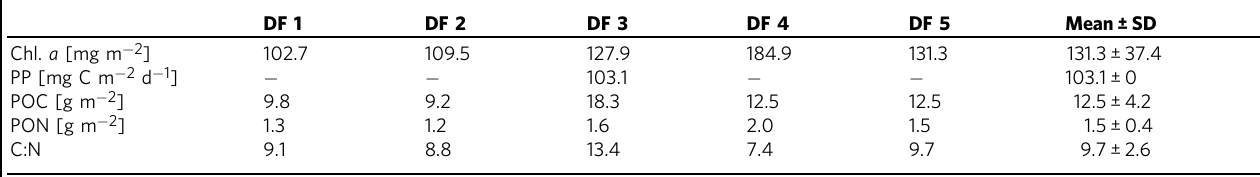
Table 1 Standing stock of chlorophyll a (Chl. a), primary production (PP), particulate organic carbon (POC), particulate organic nitrogen (PON), and the carbon to nitrogen ratio (C:N) integrated over the top 200 m.